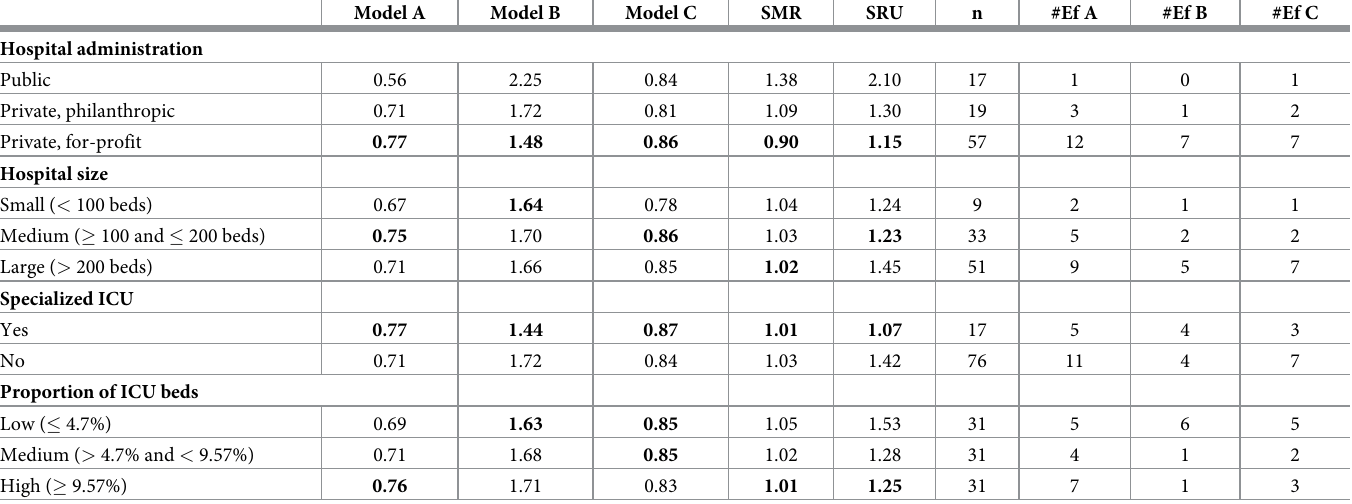
Table 5. Mean efficiency scores in each model, mean SMR and SRU, number of units in each category, and number of units considered efficient in each model. The best results in each category and column are in